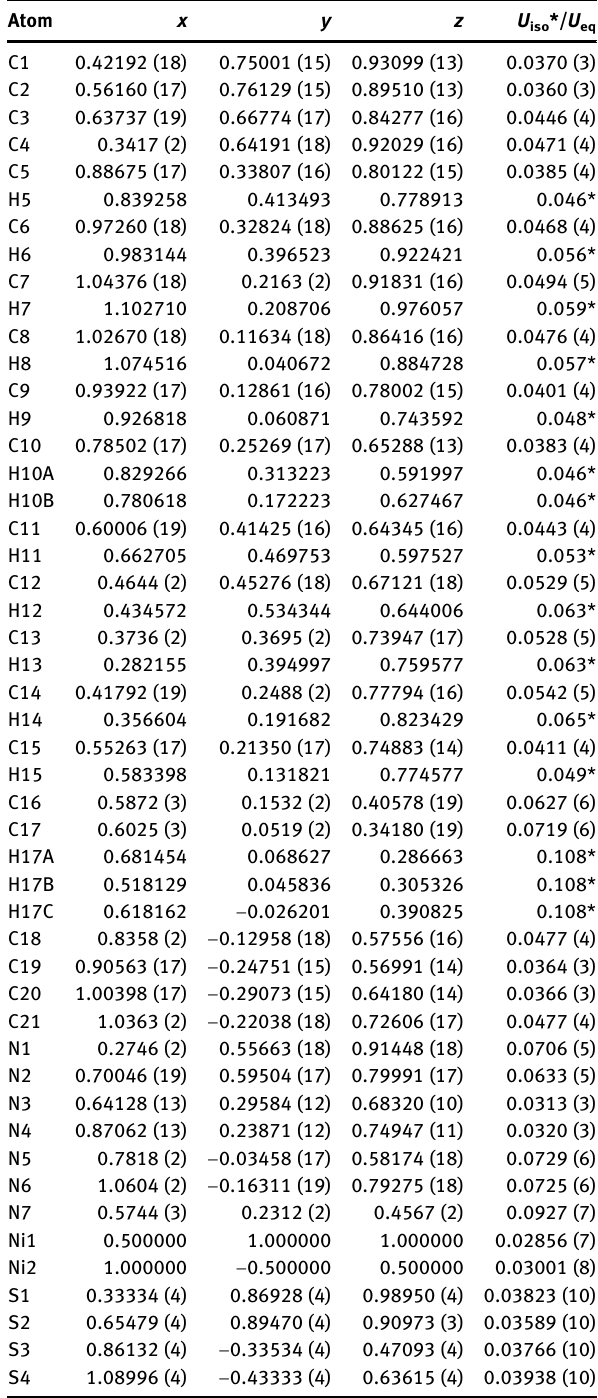
Table  : Fractional atomic coordinates and isotropic or equivalent isotropic displacement parameters (Å 